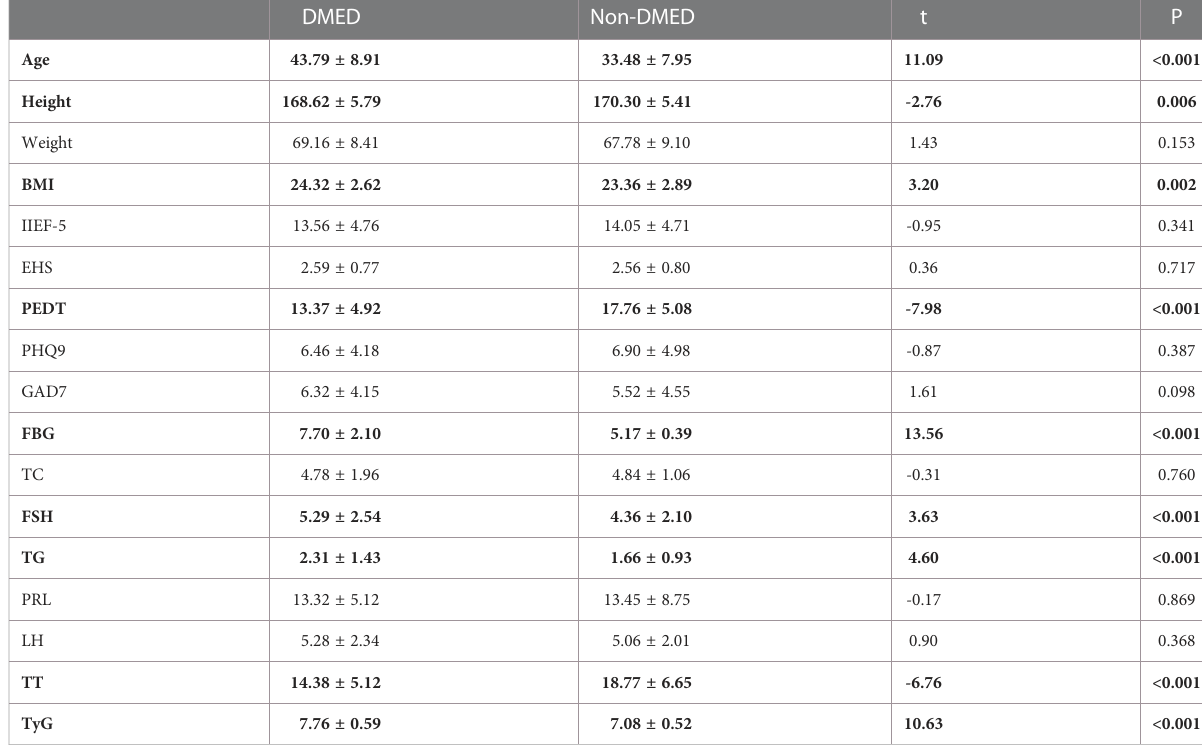
TABLE 2 Comparison of the Characteristics between the Two Groups (DMED vs